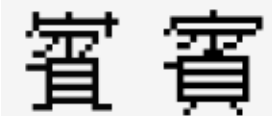
Figure 12. This Chinese, Japanese, Korean (CJK) Compatibility Ideographs and CJK Unified Ideographs pair confuses both CNN | 1 Scratch , CNN | 2 Scratch and eventually the final ensembled